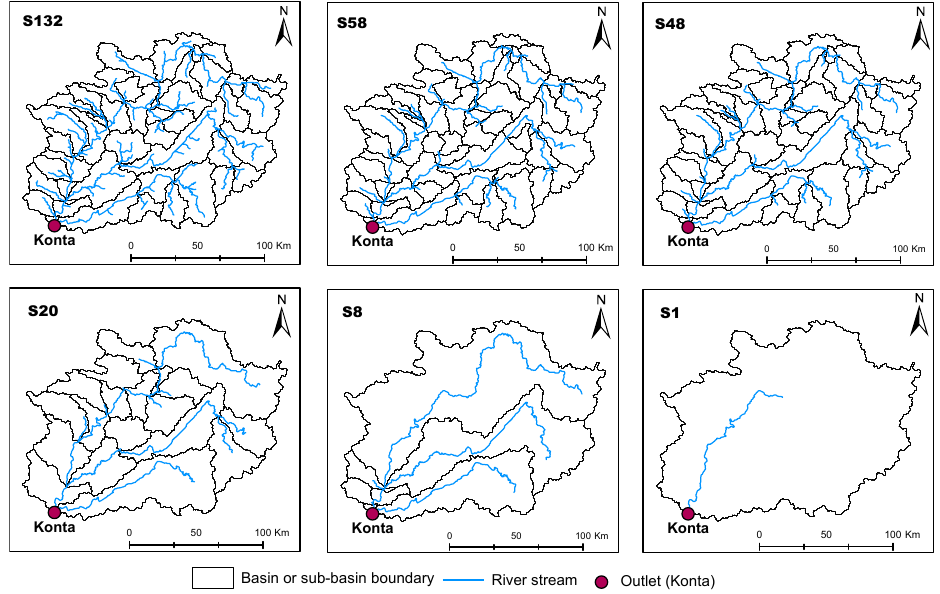
Figure 2. Delineation of Sabari river basin for six different configurations. Several topographical parameters, i.e., area, longest flow path, elevation, average channel slope, average basin slope and basin lag, were calculated for all the sub-basins for the six spatial resolutions. Table 5 displays basin/sub-basin average values of topograph- ical parameters. As the spatial resolution became finer, the sub-basin average values of parameters were decreased. The values for the six configurations differed significantly suggesting basins of a different order. The relation between area and physical characteristics was found to be a power-law; thus, the characteristics exhibited scaling with respect to the basin or sub-basin area. Table 5. Average values of topographical parameters of Sabari River Basin. The values for six configurations were calcu- lated by taking the average value of all sub-basins of the corresponding configuration. Here, A t is the threshold area used to delineate the configuration, A ̅ is the mean area of the basin, L ̅ is the mean longest flow path, and Lag is the basin lag. Configuration